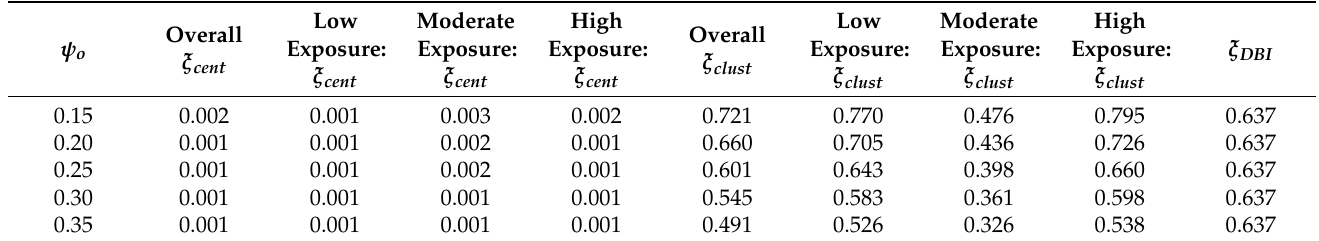
Table 21. Sensitivity analysis of the proposed method for the assignment of